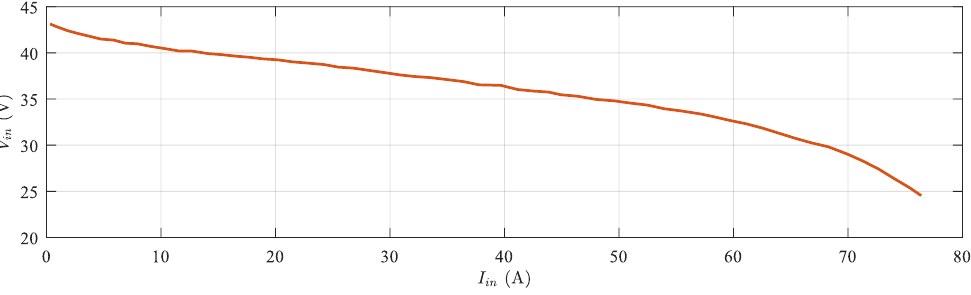
Figure 3. H-2000 PEMFC voltage–current